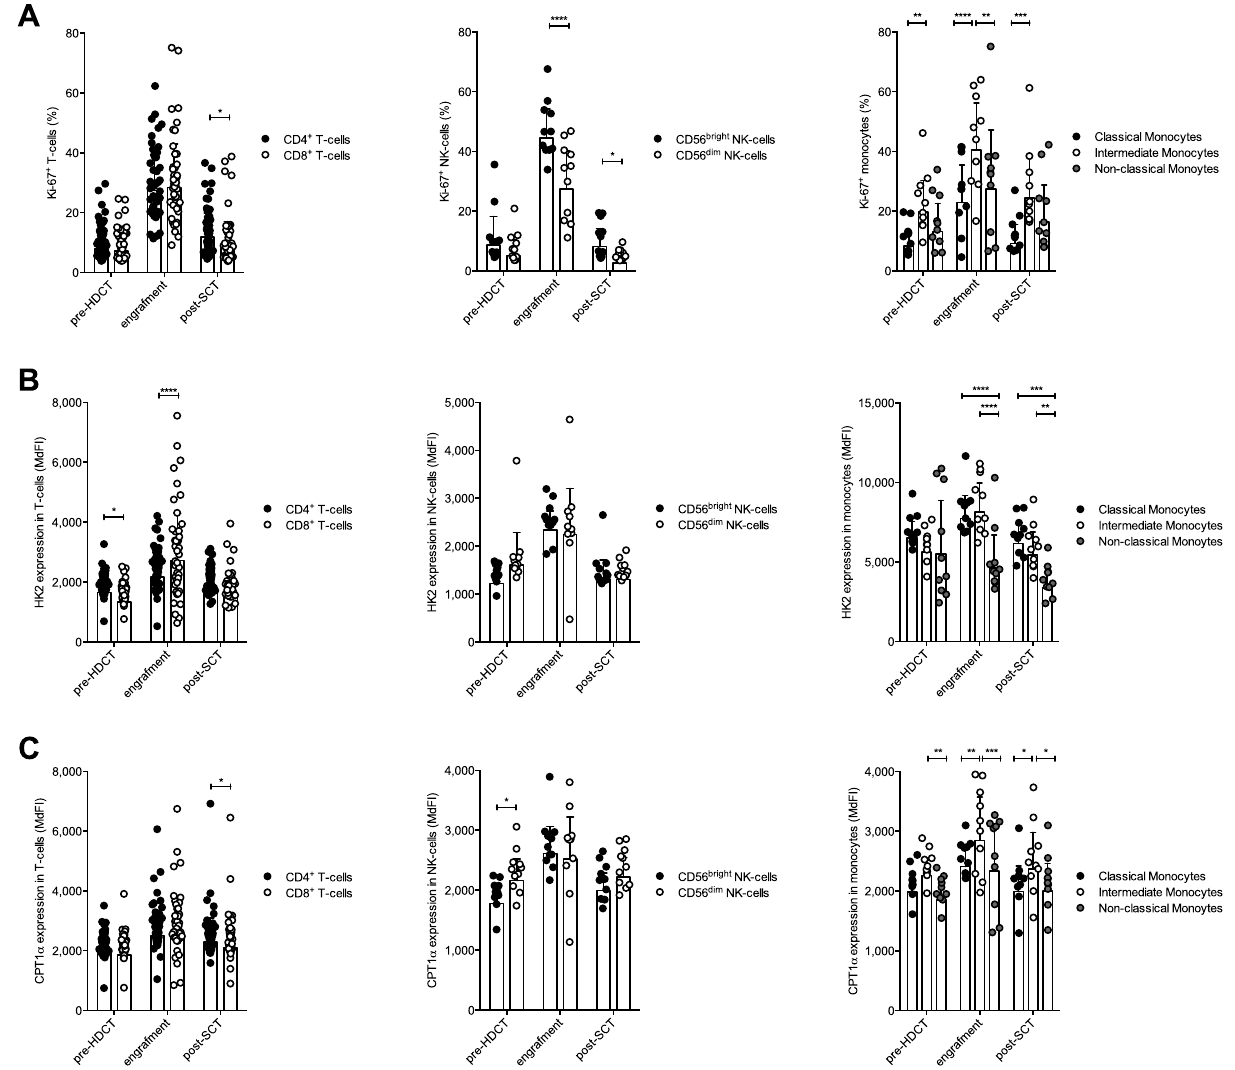
Figure 5. Proliferative activity and metabolic armamentarium are not homogenous within T-cell, NK-cell, and monocyte subpopulations following HDCT/auto-SCT. ( A ) Proliferation of T- and NK-cell as well as monocyte subsets was evaluated by plotting the percentages of Ki-67 + cells during the three different time points. ( B ) The glycolytic pathway was analyzed by measuring the expression of HK2. ( C ) The FAO pathway was analyzed by measuring the expression of CPT1α. All results of the latter two markers were plotted as median fluorescence intensity (MdFI) for all cell populations (n: 43 (T-cells), 11 (NK-cells), 10 (monocytes), mean values +/− SD). Statistical significance was determined using a two-way ANOVA with Sidak’s multiple comparison tests for paired comparisons between T-, NK-cell and monocyte subsets. *P < .05; **P < .01; *** < .001; ****P <